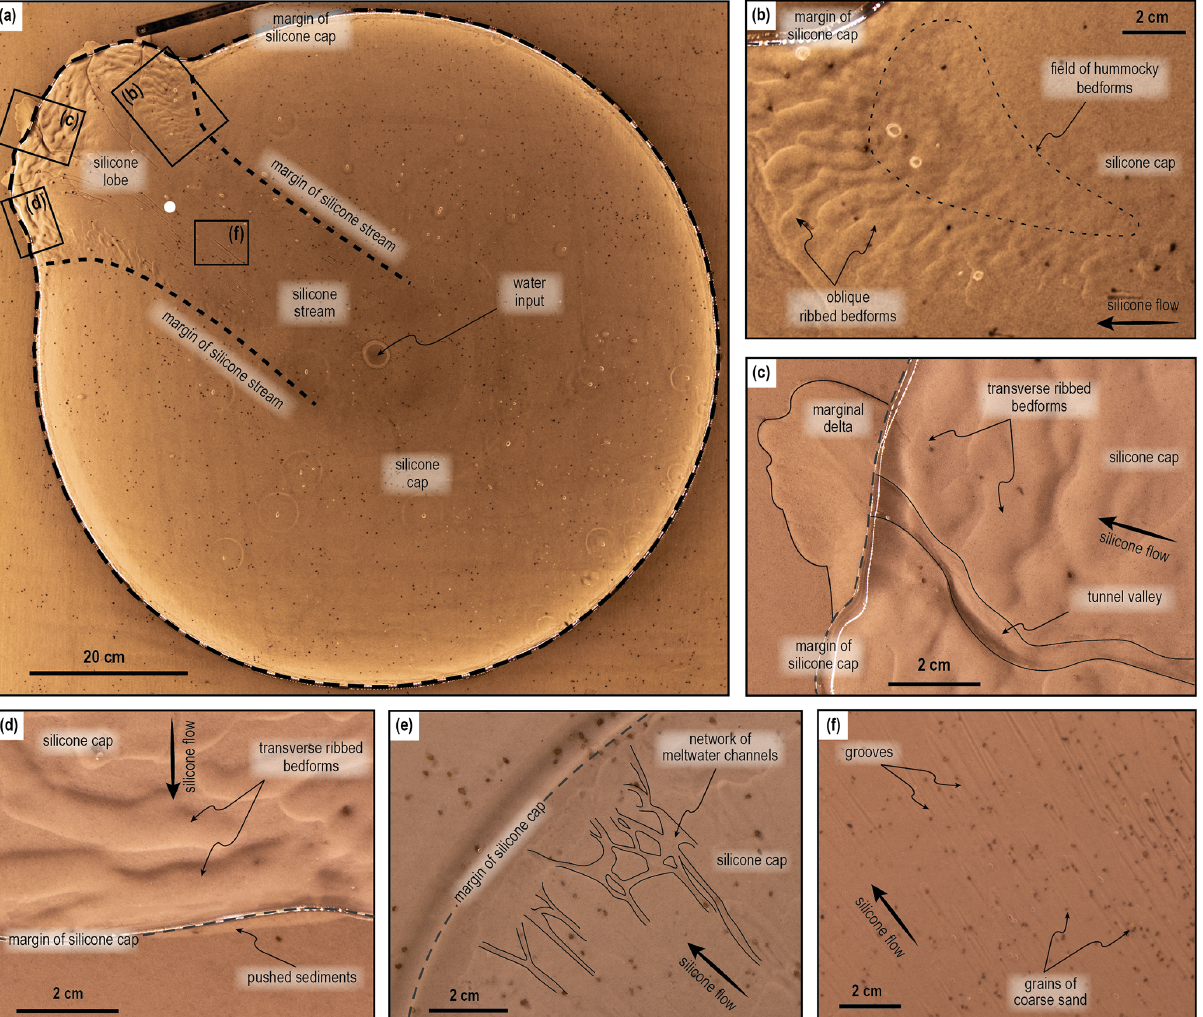
Figure 5. Illustration of bedform assemblages produced during the experiments. (a) Overall surface view of the silicone cap at the end of an experimental run, showing the distribution of bedforms beneath a stream/lobe system characterized by well-developed channelized drainage (Experiment 10). The white dot indicates the position of the pressure sensor where pore water pressure presented in Fig. 4 is measured. (b) Close-up on oblique ribbed and hummocky bedforms observed at the right lateral shear margin. (c) Transverse ribbed bedforms parallel to the lobe frontal margin and formed submarginally. Tunnel valley and associated marginal delta. (d) Transverse ribbed bedforms parallel to the lobe frontal margin and pushed marginal sediments bulldozed by the lobe margin. (e) Network of meltwater channels extending parallel and perpendicularly to the silicone flow (not located in panel a , because it was observed in Experiment 14, characterized by poorly developed channelized drainage). (f) Field of grooves inscribed in the bed and oriented parallel to silicone flow with embedded sand grains at the grooves’ downstream